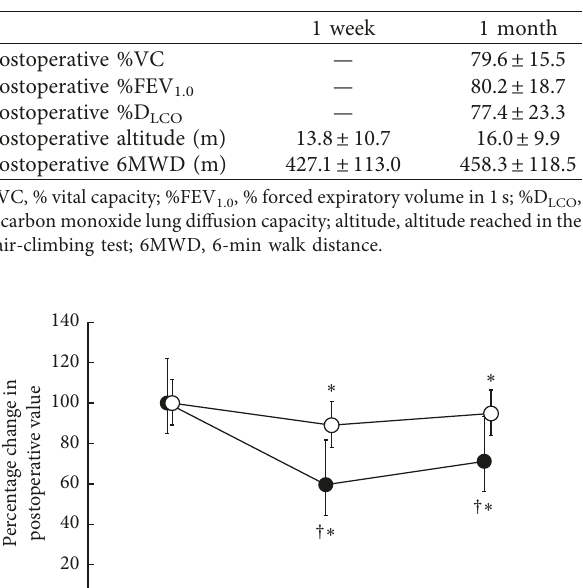
Table 2: Results of pulmonary function and exercise capacity after lung resection.